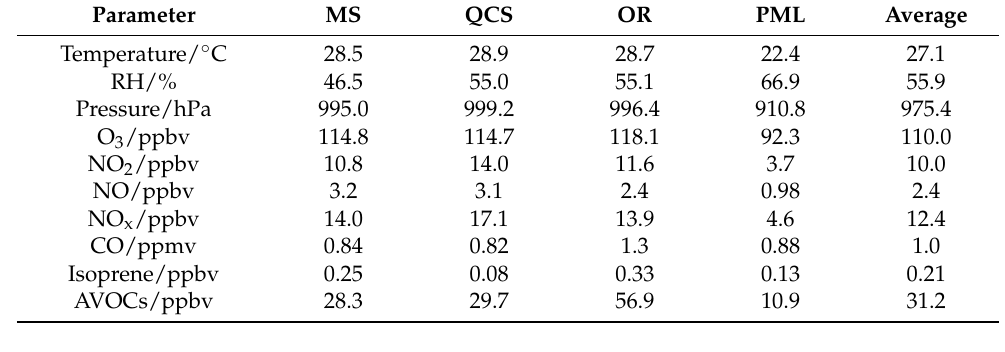
Table 1. Mean values of meteorological parameters and pollutant volume fractions at each site in June 2021.